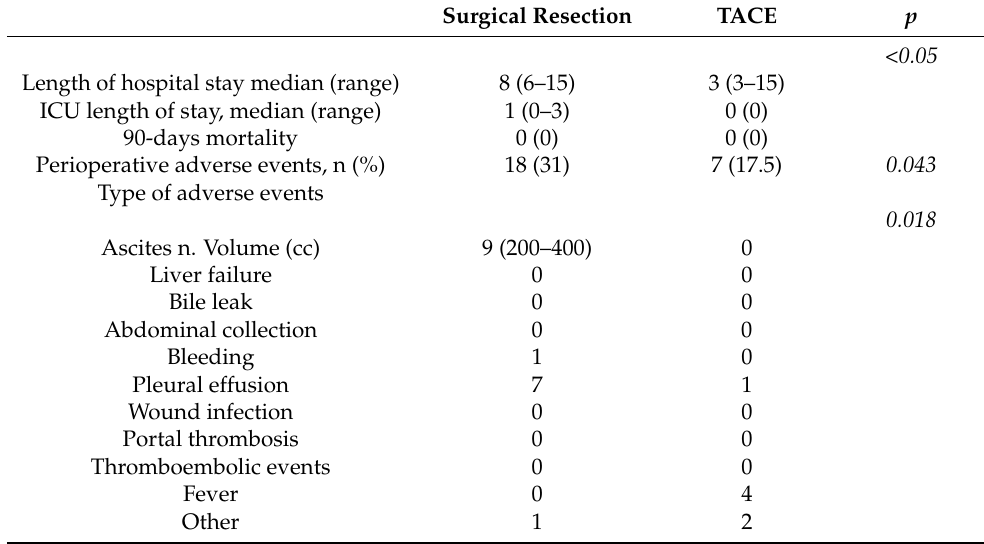
Table 6. Early outcomes in BCLC-B patients according to type of